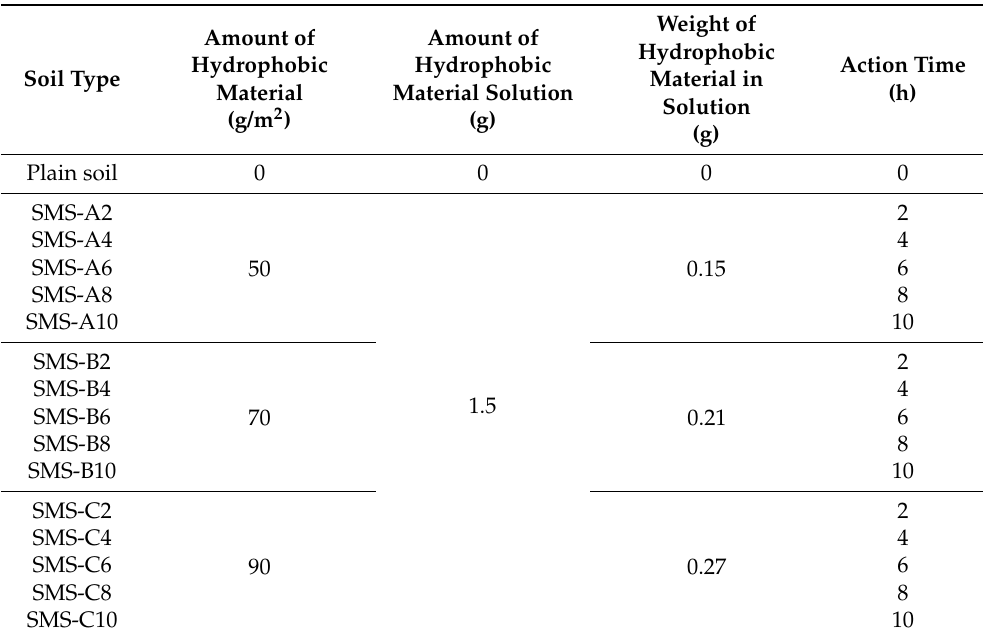
Table 2. Dosage and action time of hydrophobic